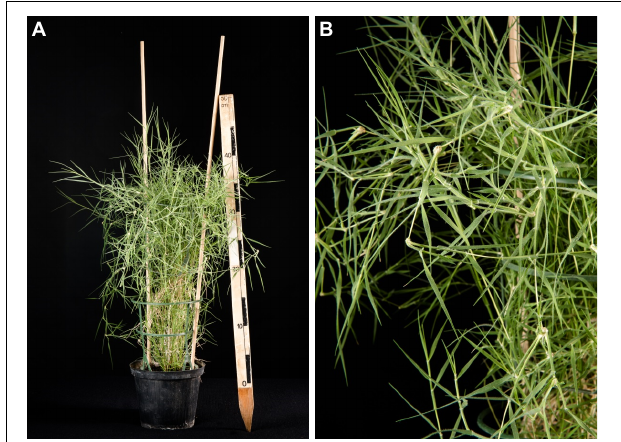
FIGURE 1 | (A) Aeluropus littoralis cultivated in pots under greenhouse condition. (B) Enlargement of leaves. Black and white box on the ruler represents 5